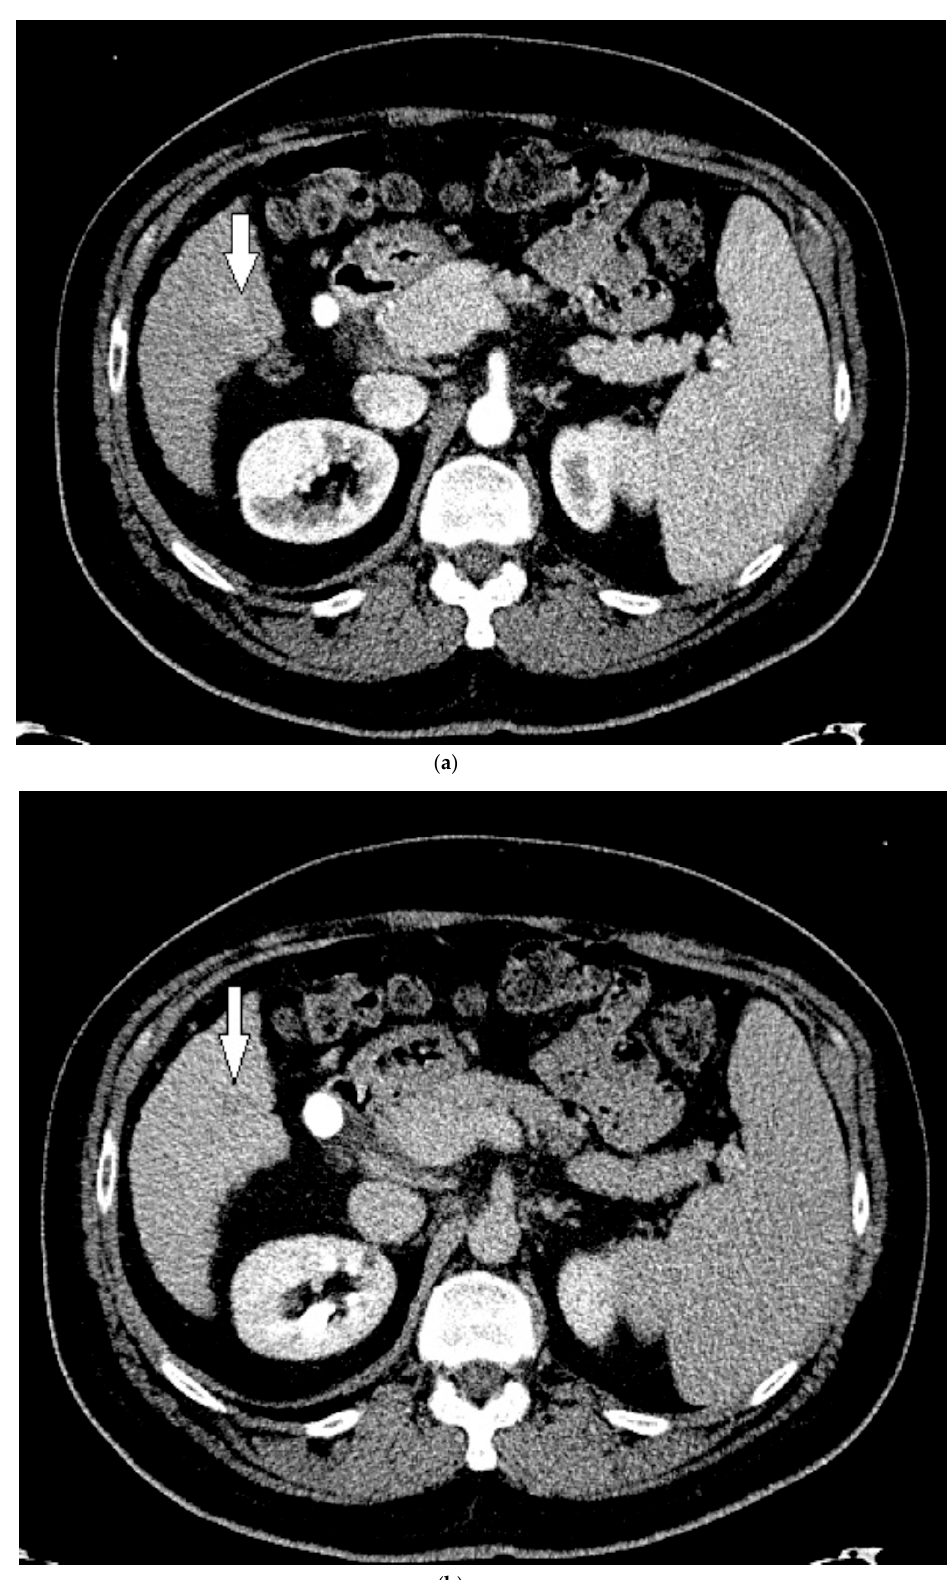
Figure 4. Patient 2 CT images using liver windows to highlight the lesion seen on CEUS (white arrow): ( a ) late arterial phase axial contrast-enhanced CT; ( b ) 3 min delayed phase.